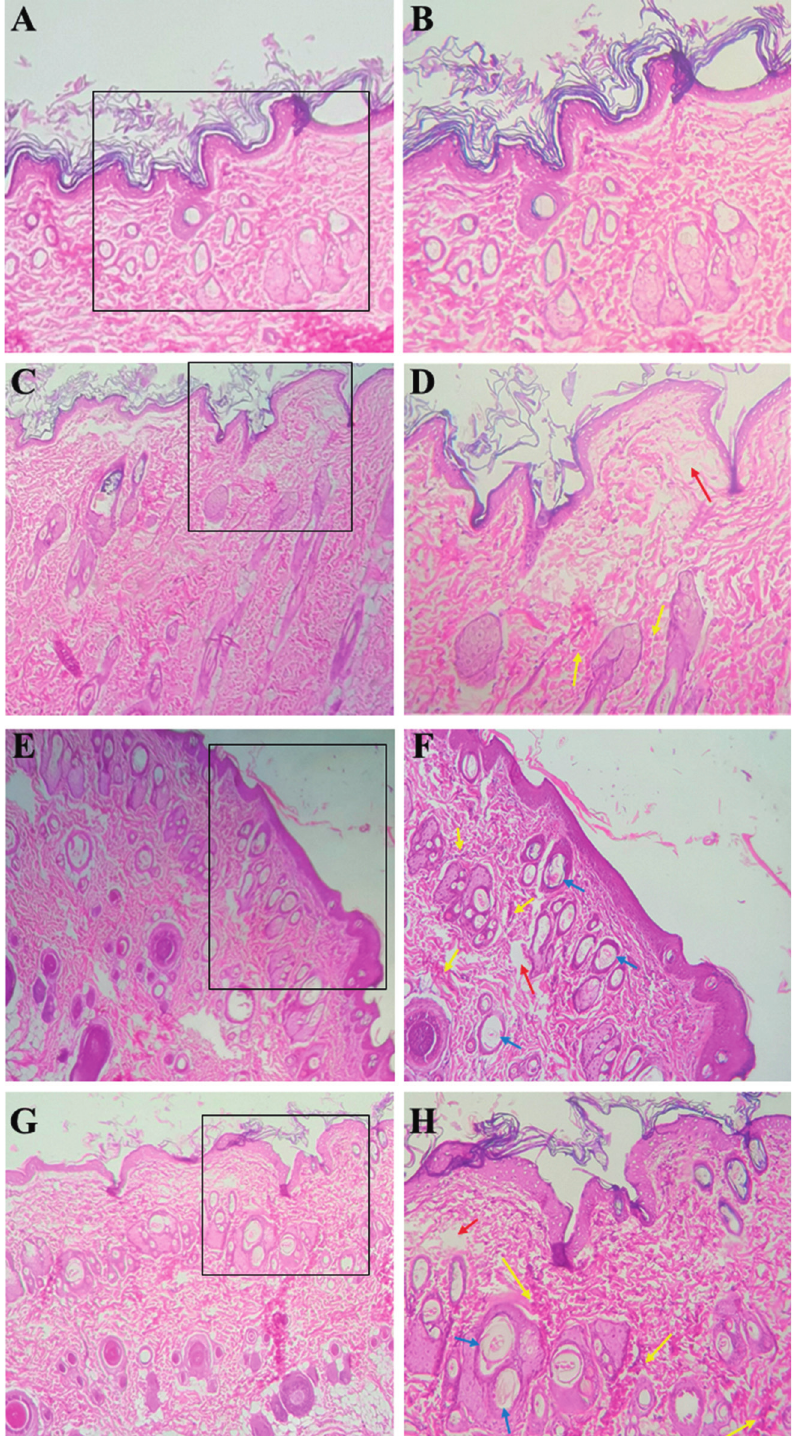
Figure 5: Histological analysis (thickness, inflammatory cell infiltration, collagen fiber regulation conditions) on day 1. Sham group (A; × 40, B; × 100), control (C; × 40, D; × 100), betamethasone (E; × 40, F; × 100), ASC groups (G; × 40, H; × 100) (red arrows: collagen necrosis; blue arrows: collagen bundles; yellow arrows: inflammatory cells